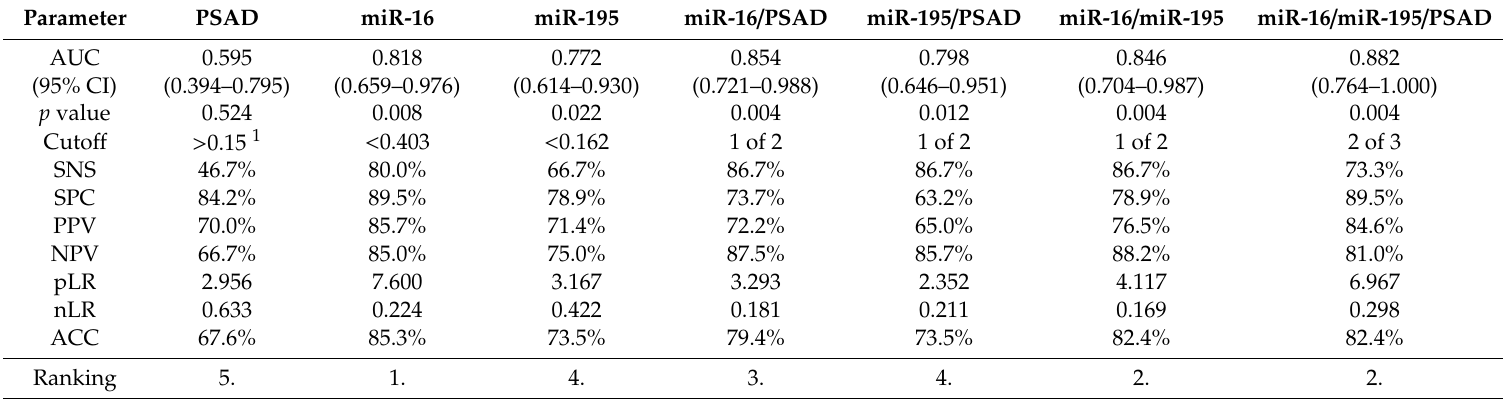
Cuto ff values were kept the same as in the ROC curve analysis using the whole study cohort. Ranking of diagnostic performance was achieved by comparing the diagnostic parameters AUC, SNS, SPC, PPV, NPV, pLR, nLR, and ACC. P values calculated by the ROC curve analysis were corrected for multiple comparisons by the Benjamini–Hochberg method. 1 unit: ng / mL